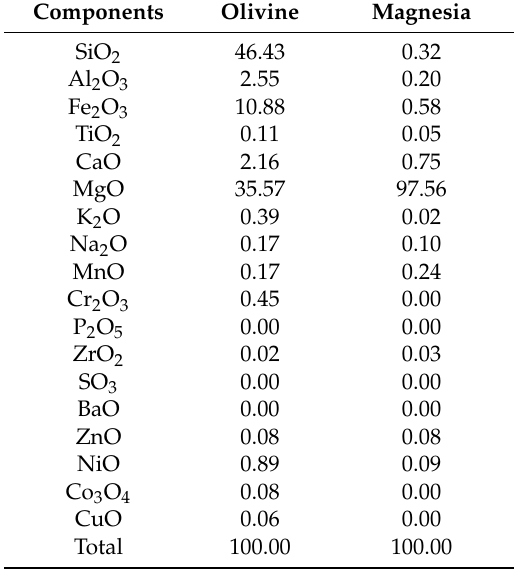
Table 1. Chemical composition of the investigated olivine and magnesia in wt%.